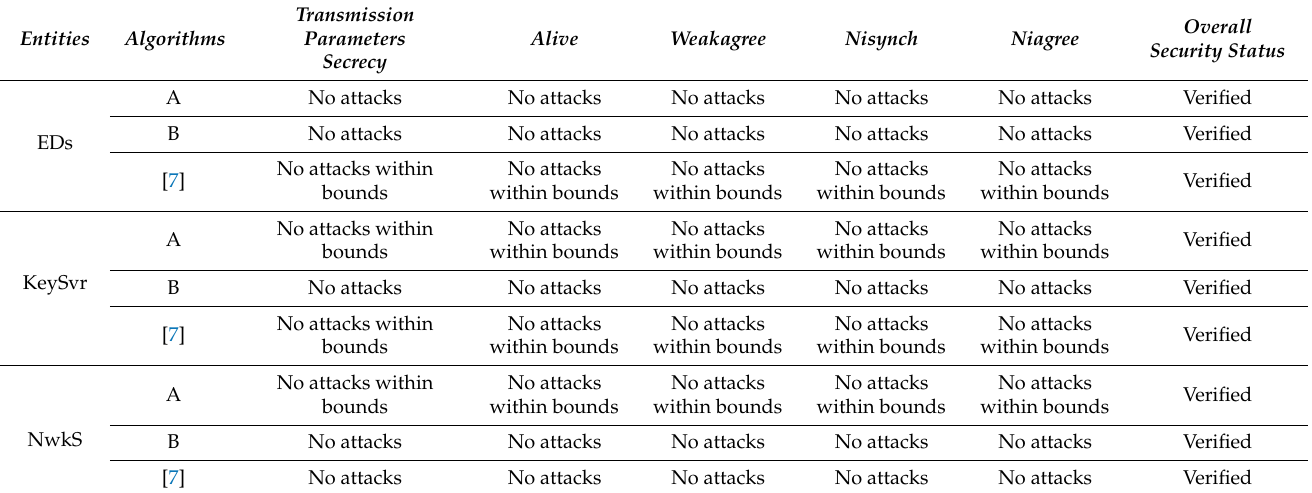
Table 6. Comparison of proposed algorithms automatic security evaluation with similar